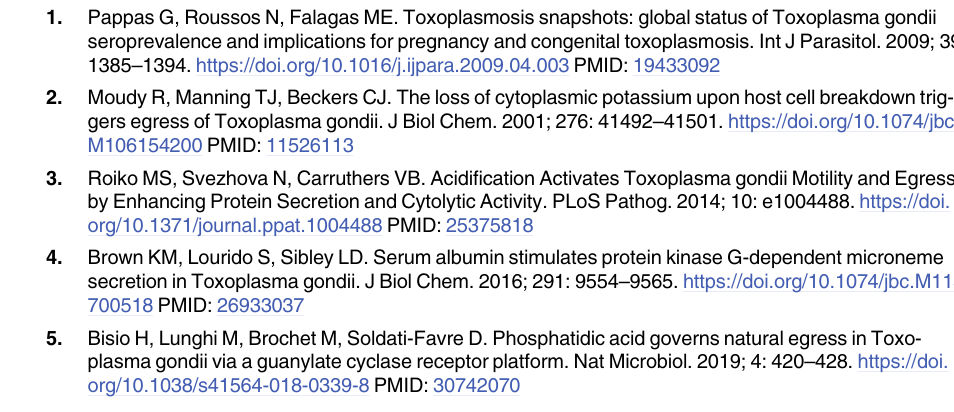
S5 Table. Gene ontology analysis results of protein found to be differentially down-regulated and CDPK3 dependent in A23187 timecourse. S6 Table. List of primers used in this